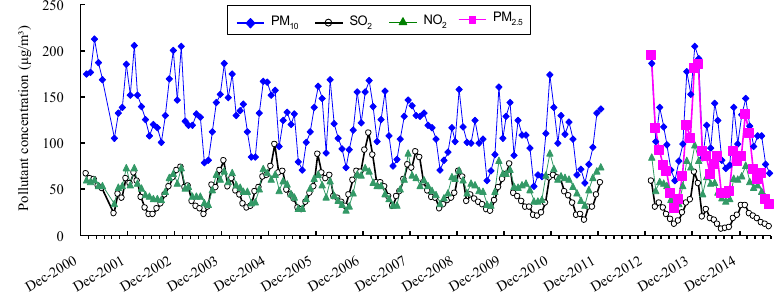
Figure 5. Monthly average concentrations of pollutants during 2001–2014.